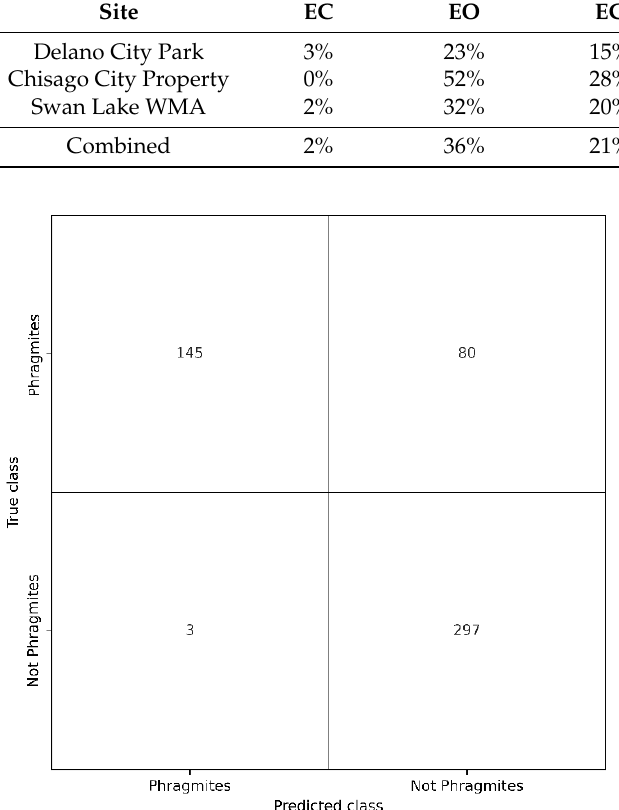
1 Table 17. Errors of commission (EC), errors of omission (EO), and Matthews correlation coefficient (MCC) values for the random forest classification with the post-ML OBIA rule set. Phragmites Class